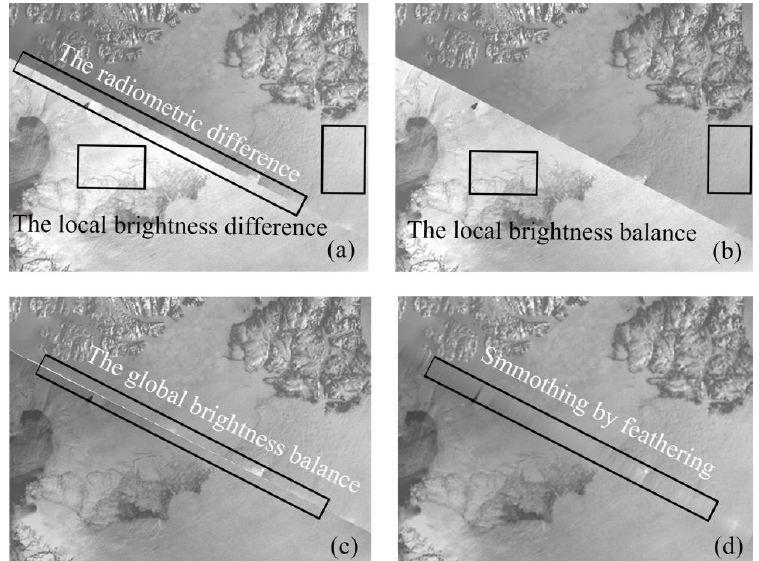
Figure 16. The process of local to global brightness balancing. ( a ) Original image. ( b ) The result after using brightness compensation model of local to global radiometric balancing. ( c ) The result after using brightness approach model of local to global radiometric balancing. ( d ) The result after feathering.